Question: Write a single sentence explaining what this figure depicts.
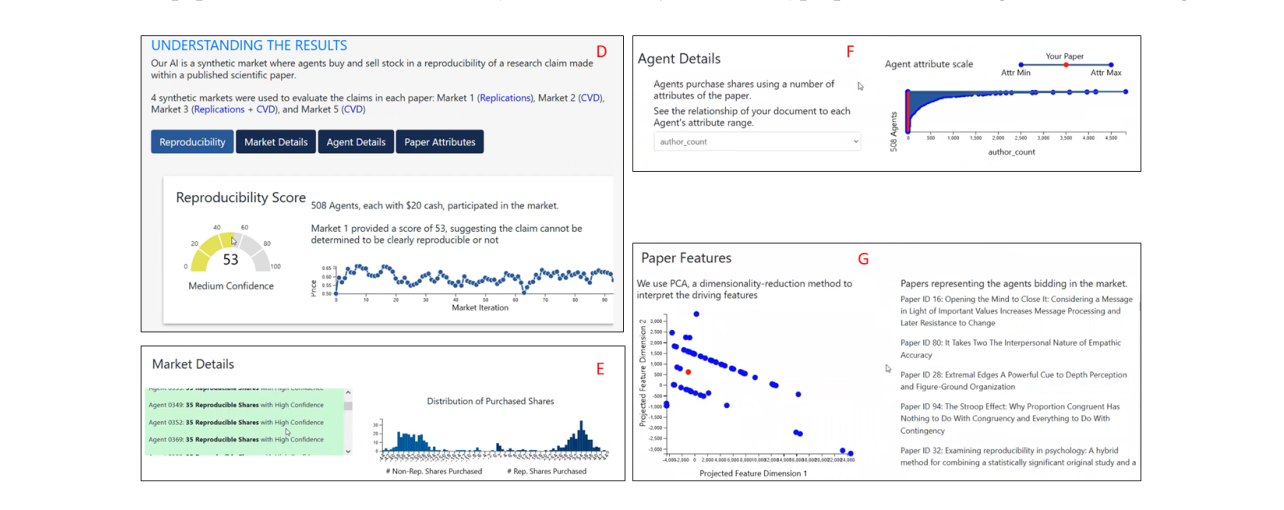
Answer: Example display of paper evaluation results. D: Replicability score. E: Explanations, presented as details about agents’ behaviors/decisions; F: Publication’s features in context; G: Visualization of principal components from extracted features.